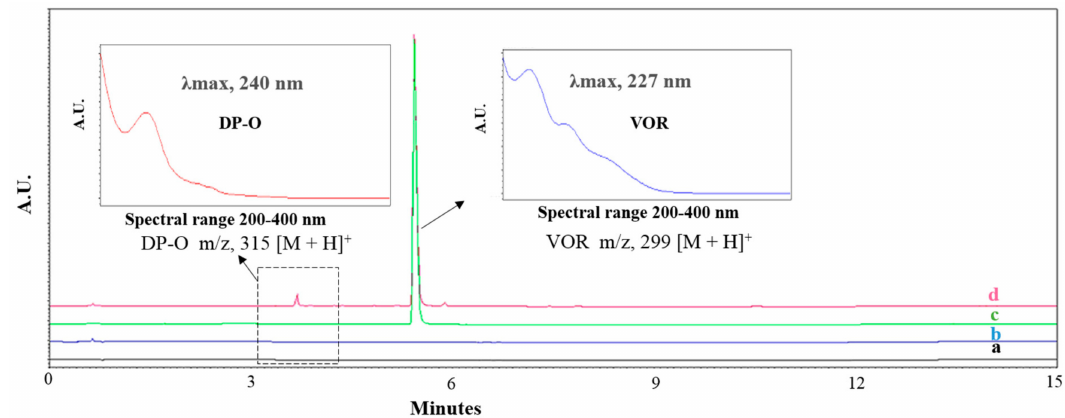
Figure 1. Representative overlay of chromatograms ( a ) Blank sample diluent; ( b ) Blank PVP hydrogen peroxide (PHP) complex; ( c ) vortioxetine hydrobromide (VOR) reference solution; ( d ) VOR-PHP storage sample, showing VOR and oxidative degradation product DP-O (insets denotes UV spectra of drug, VOR and its degradation product,